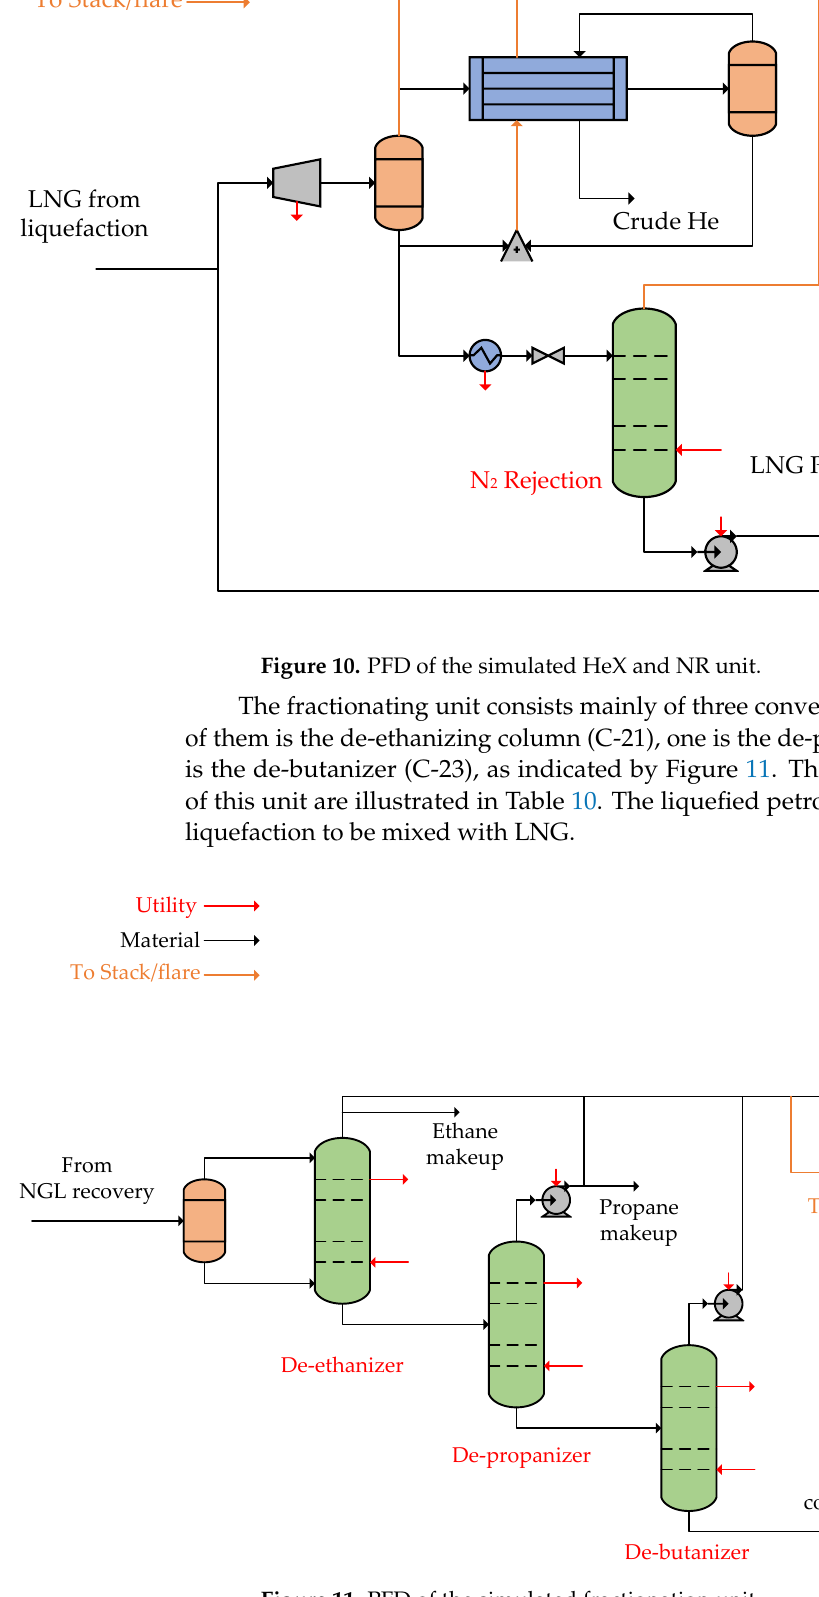
Figure 11. PFD of the simulated fractionation unit.